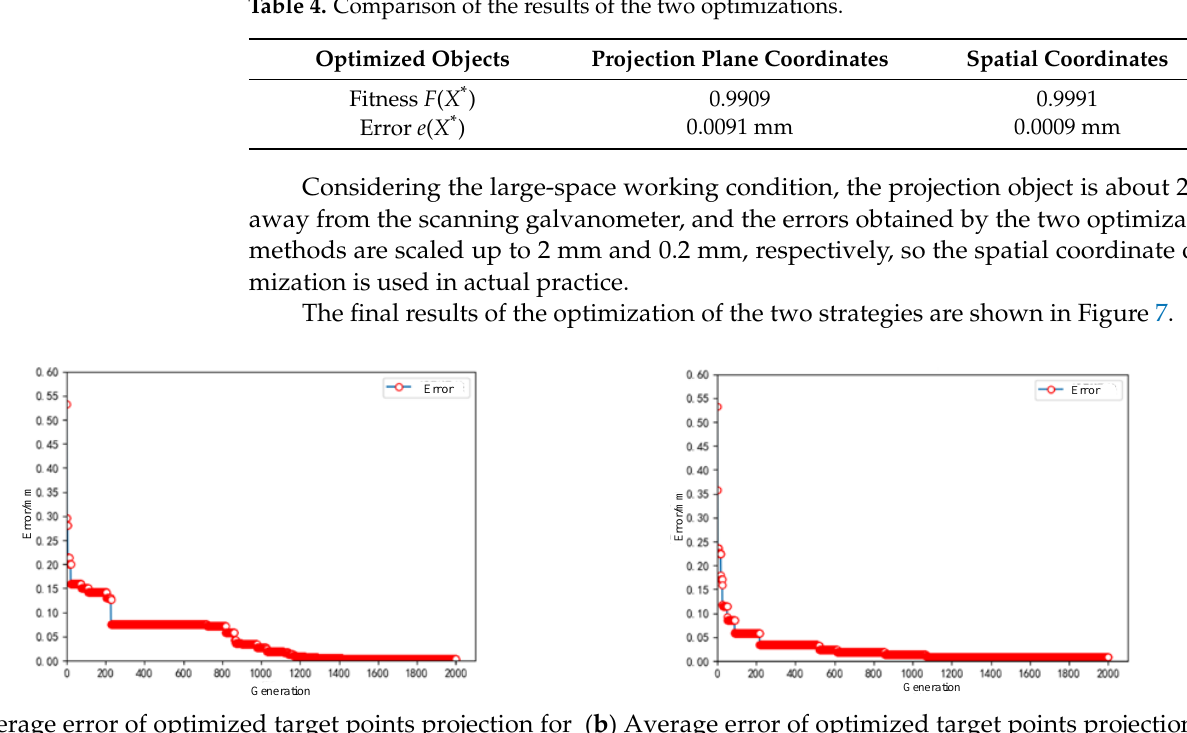
Table 4. Comparison of the results of the two optimizations.